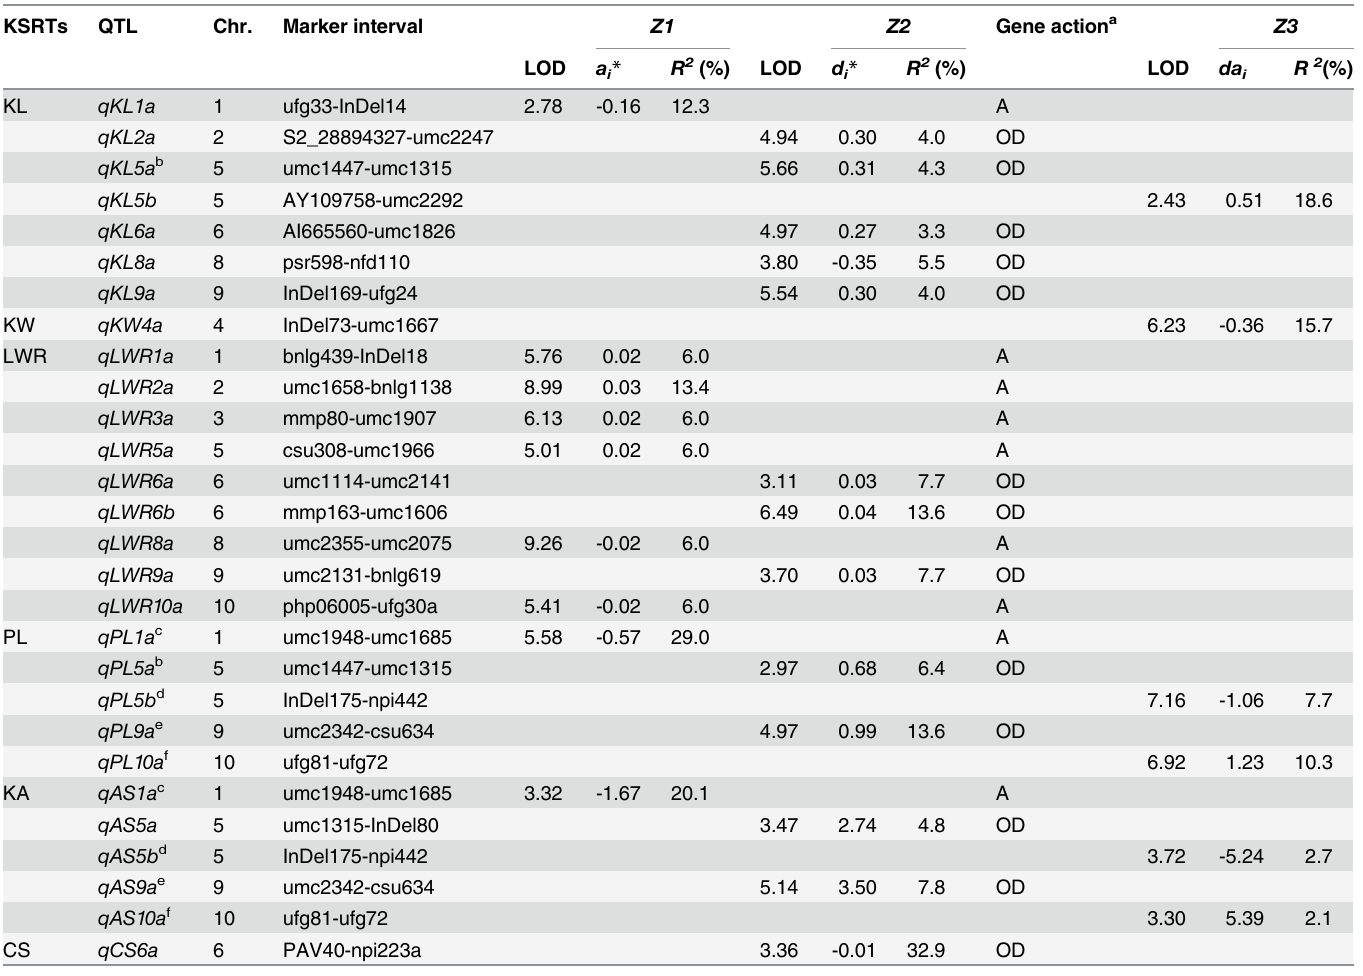
Table 4. QTLs for KSRTs detected in Z1 , Z2 , and Z3